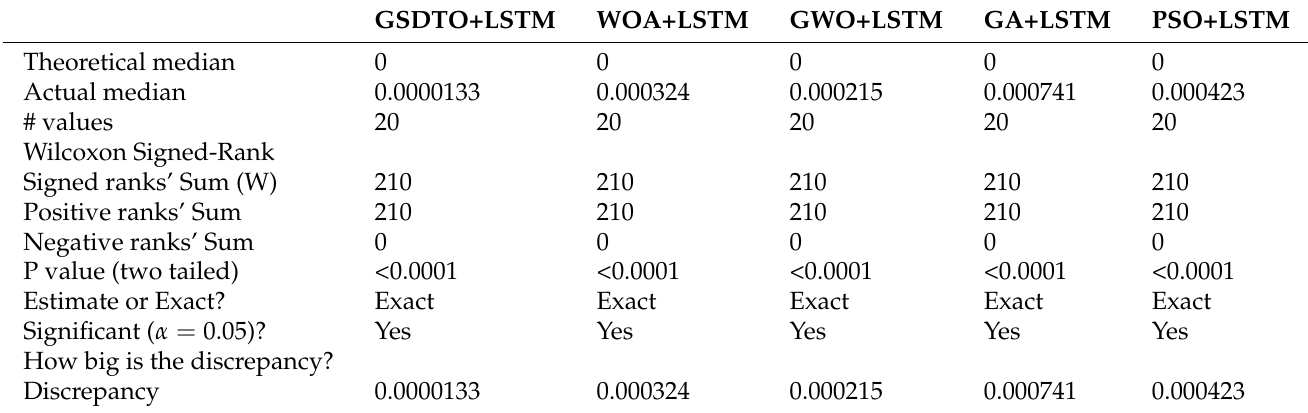
Table 13. Proposed and compared classifiers Wilcoxon Signed-Rank Test results.